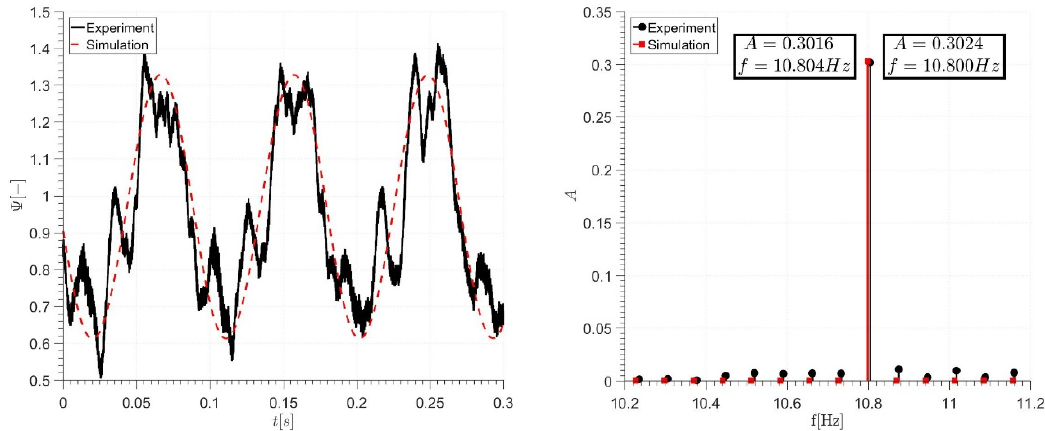
Figure 11. Comparison between experimental signal and simulation results ( left ) and frequency spectrum of experimental signal and simulation results ( right ) for φ c = 0.116.